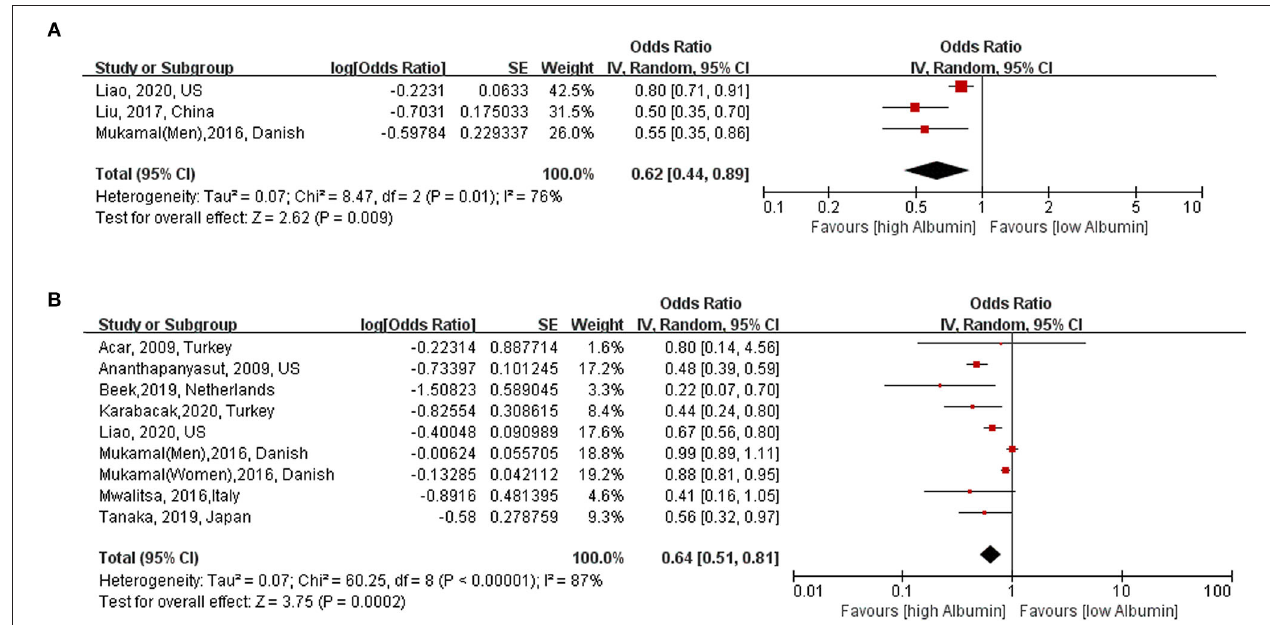
FIGURE 2 | Association between serum albumin level and risk of atrial fibrillation. (A) Category analysis (highest vs. lowest) (B ): Continuous analysis (per 10 g/L increase). AF, atrial fibrillation; OR, odd risk.